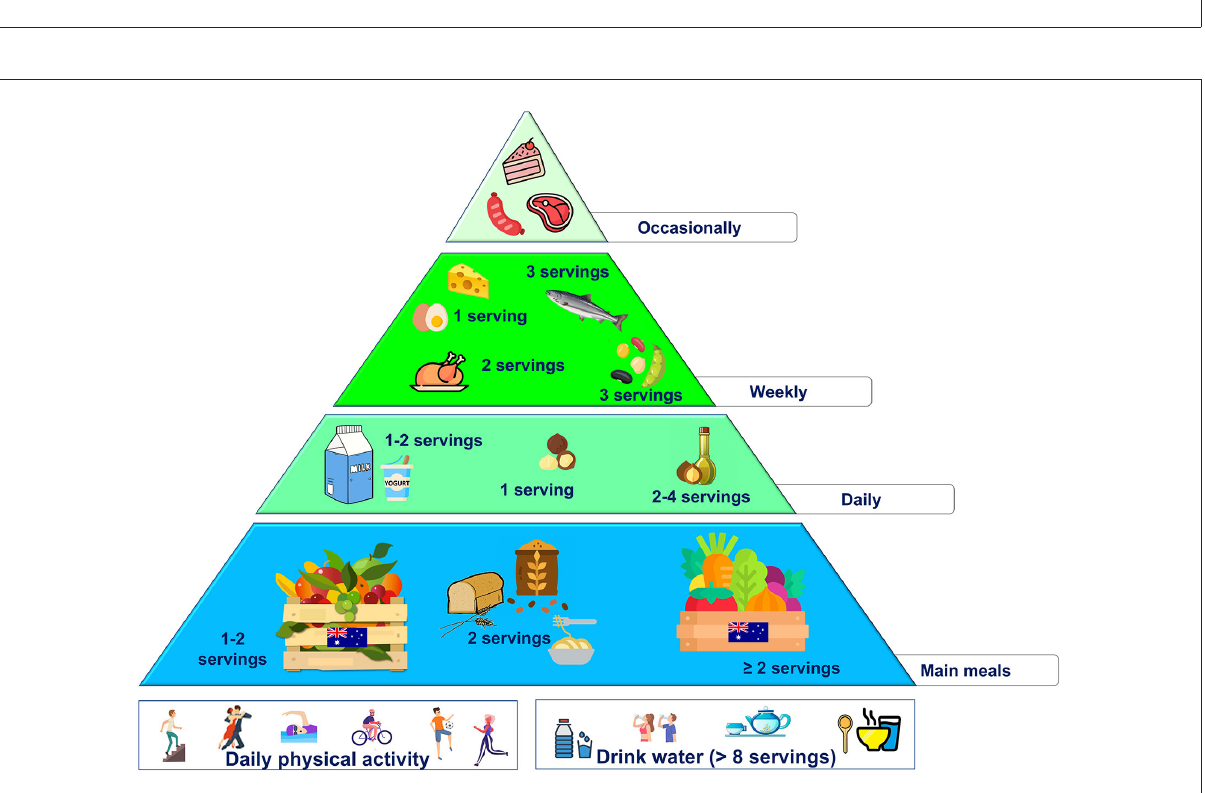
FIGURE5 Proposed nutritional pyramid for